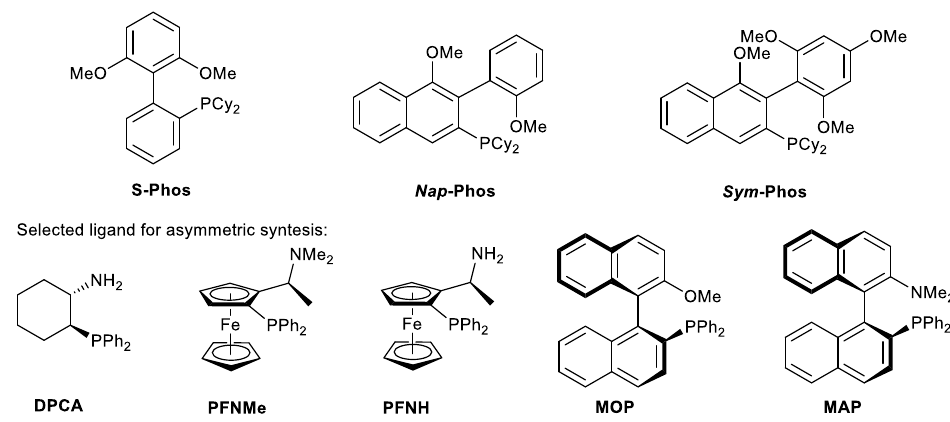
Figure 1. Highly efficient C,P-ligands and selected chiral